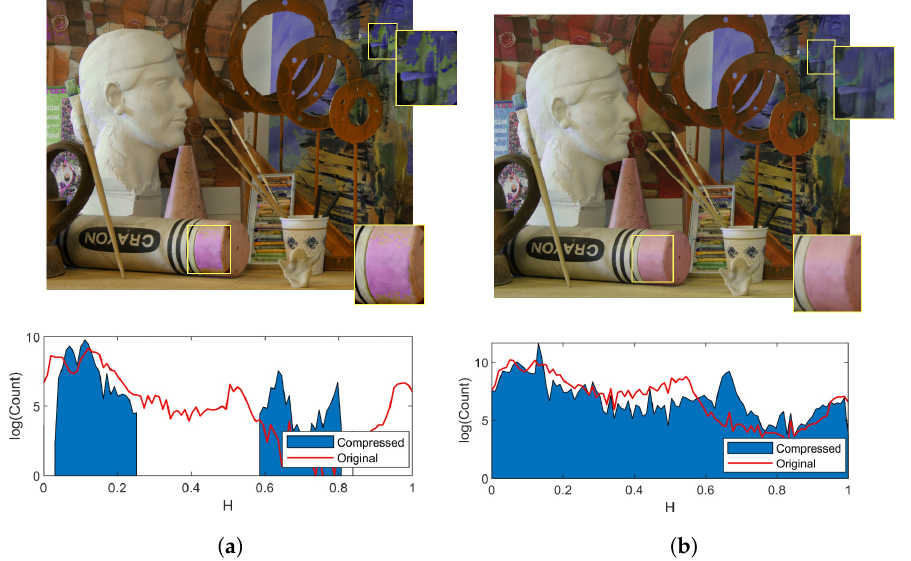
Figure 5. Gamut correction methods: color harmonization by templates ( a ); and the proposed method of nonlinear compression ( b